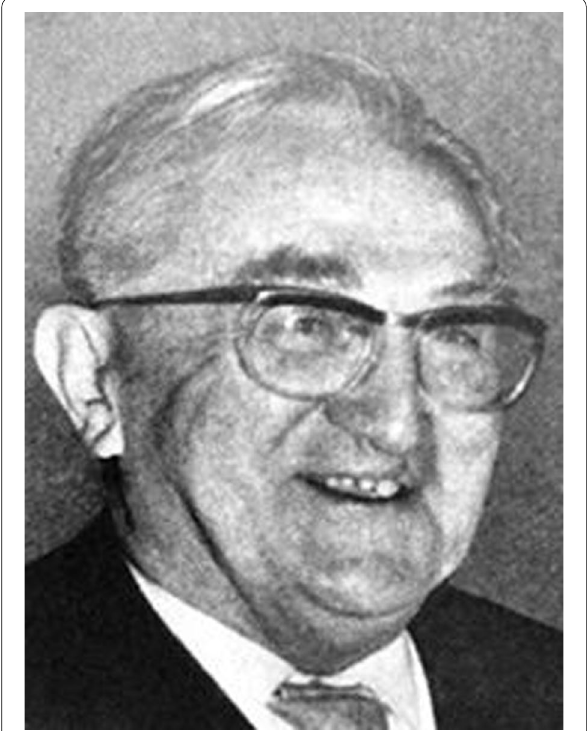
Fig. 2 Gustav Bodechtel. Undated photography, photographer unknown. Source : Steinmetz, H. History of neurology in Germany. https:// dgn. org/ uber- uns/ gesch ichte/ histo ry- of- neuro logy- in-